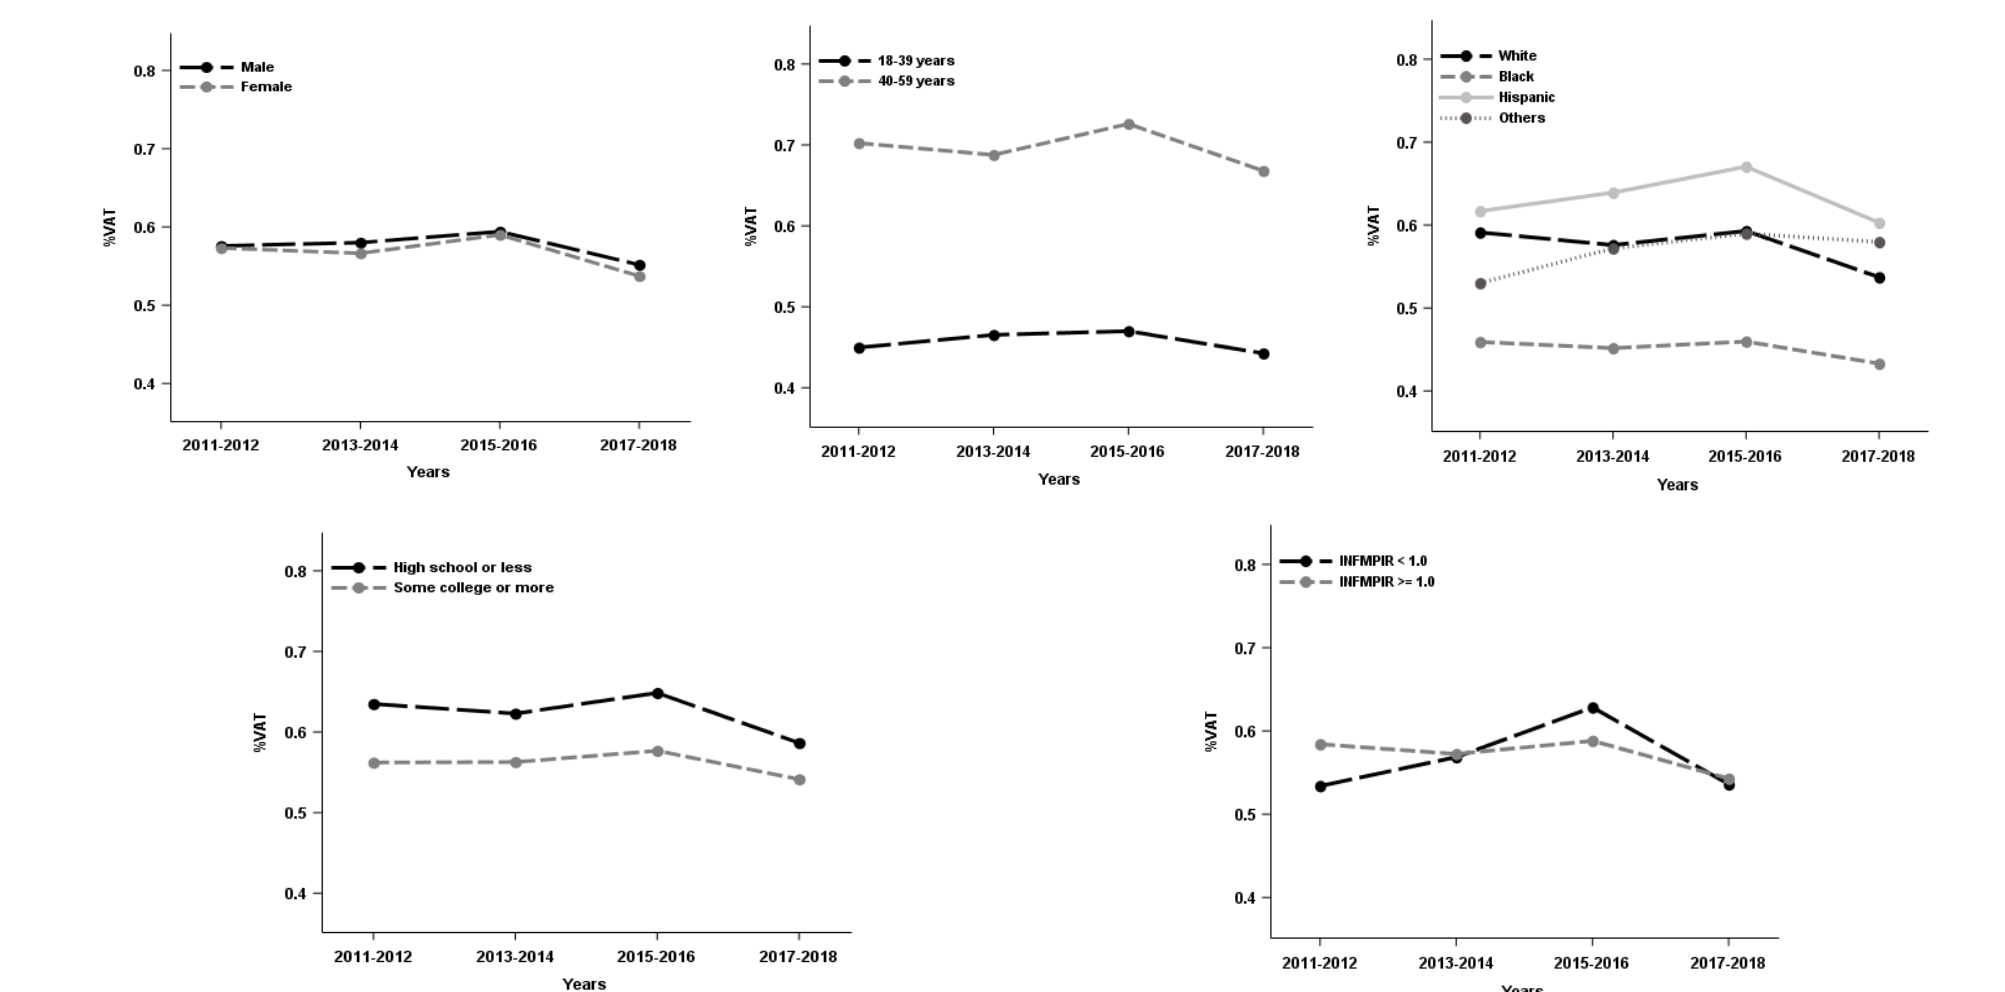
Figure 1. The mass of visceral adipose tissue relative to total body mass (VAT%) trends in US adults by demographics, National Health and Nutrition Examination Survey 2011–2018. INFMPIR = the ratio of family income to the poverty level.